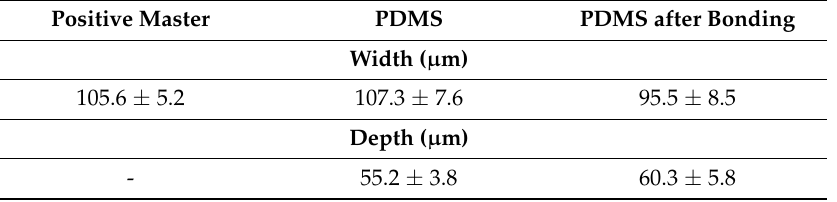
Figure 3. ( a ) Representative microscopic images of microchannels fabricated using a milling technique, captured with microscopy (IX71, Olympus Optical Co., Tokyo, Japan); ( b ) A cross-sectional view of microchannel depicted in ( a ); Scale bars indicate 50 µ m in both ( a , b ). ( c ) A photograph of the prototype microchip with red ink in the negative microchannels bonded to a glass slide. Table 5. The average and standard deviation ( n = 3) of microchannel width and depth measured after every step.